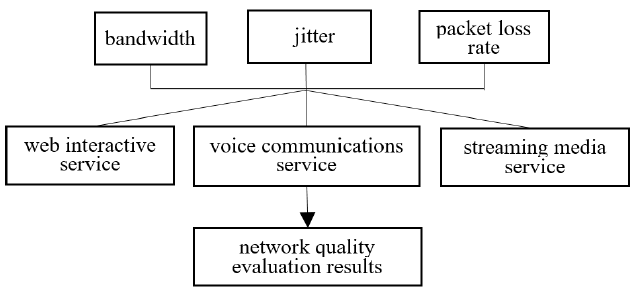
Figure 3. Evaluation hierarchy of Network Performance based on application.